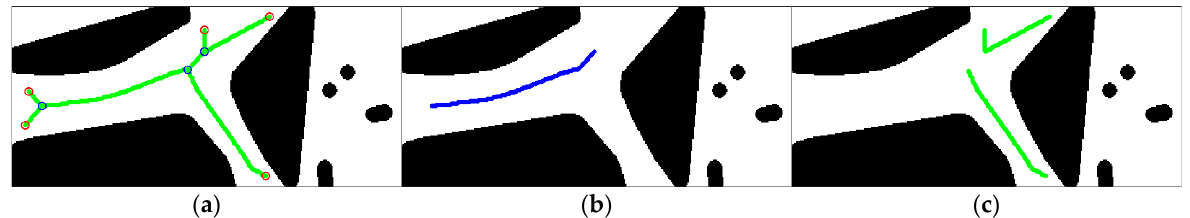
Figure 16. The process of skeleton decomposition. ( a ) Fork points and endpoints of the skeleton; ( b ) the skeleton trunk; ( c ) the skeleton branch ahead of the UGV.